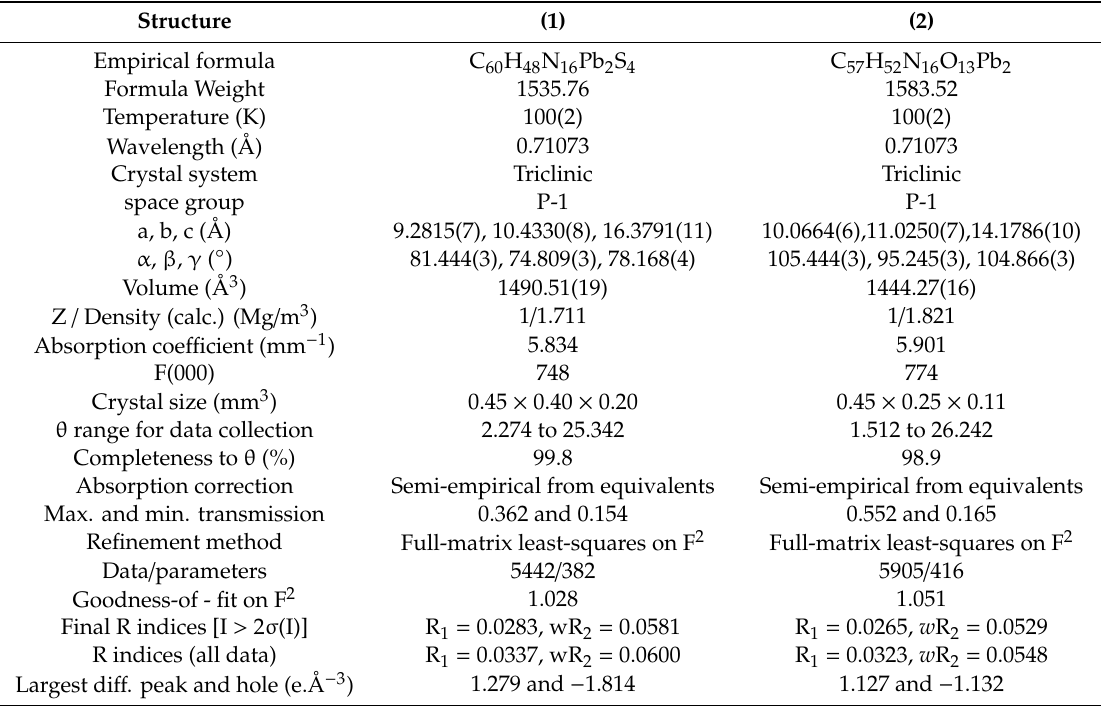
Table 1. Crystal data and structure refinement parameters for compounds ( 1 ) and ( 2